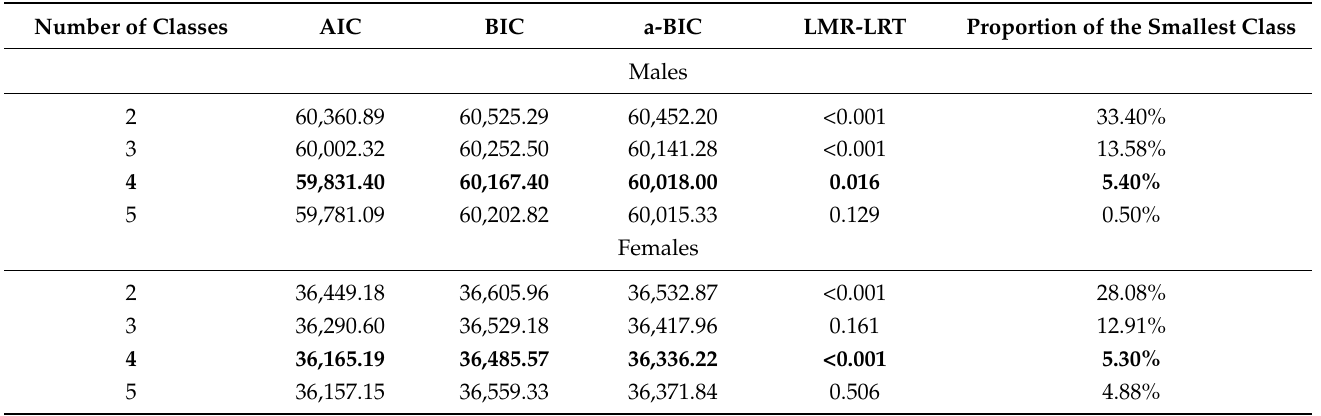
Table 2. Fit indices for two- to five-class solutions of CTE for males ( N = 9395) and females ( N = 6745).